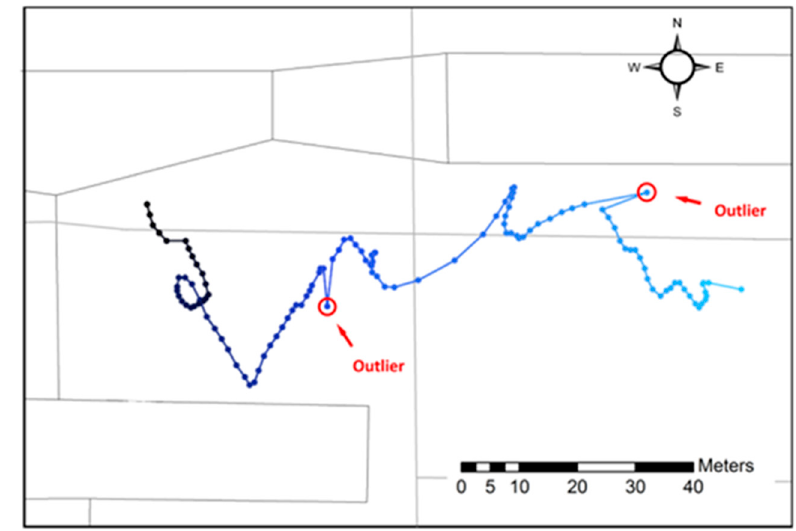
Figure 1. A GPS trajectory with two outliers.